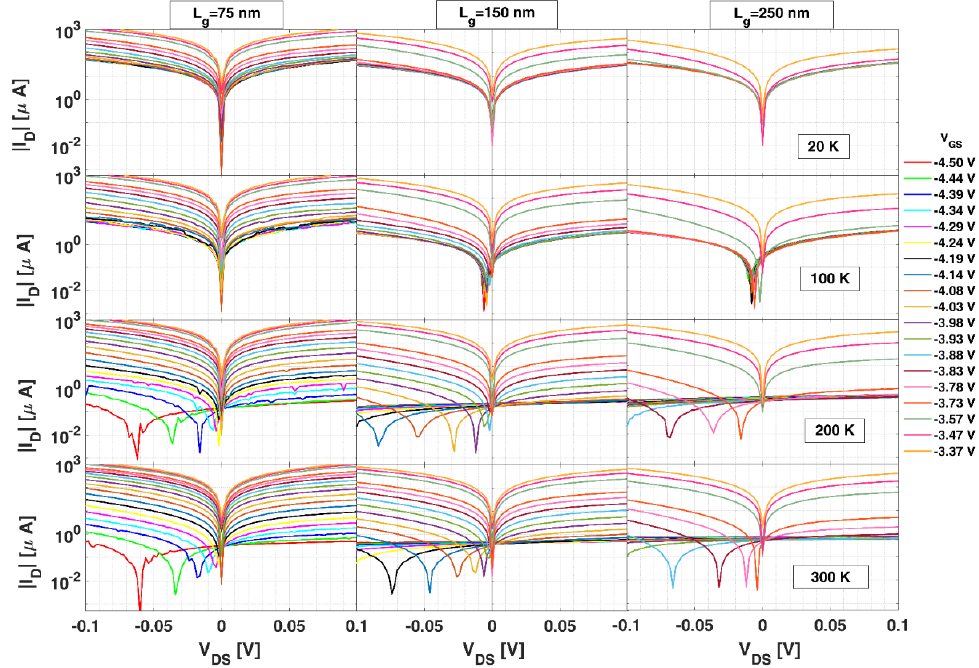
Figure 4. | I D | vs. V DS for several values of V GS in transistors with different L g measured at several T . The minimum in the curves corresponds to the value of V DS at which the current changes sign.